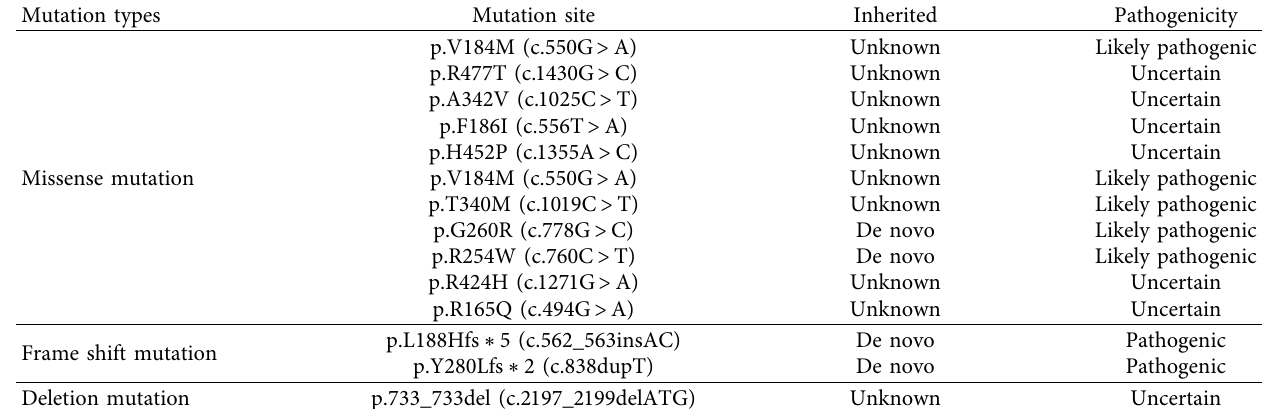
Table 1: FGFR1 mutation type, specific site information, and